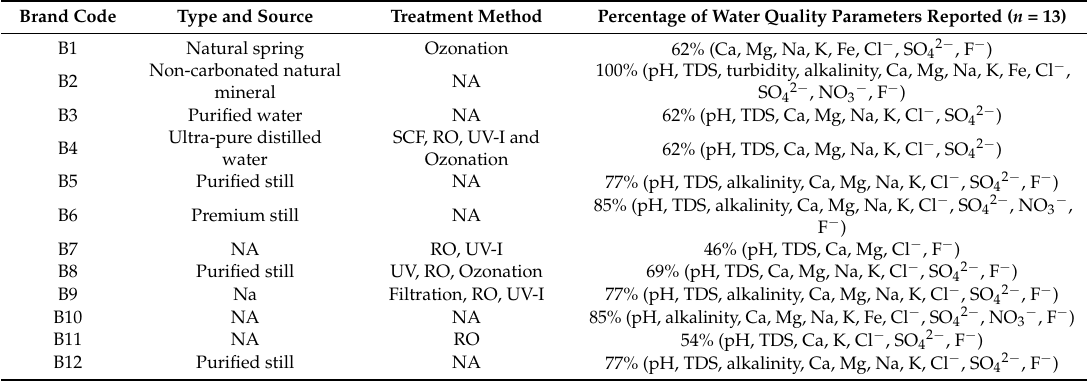
Table 1. Brand water type, source and treatment processes